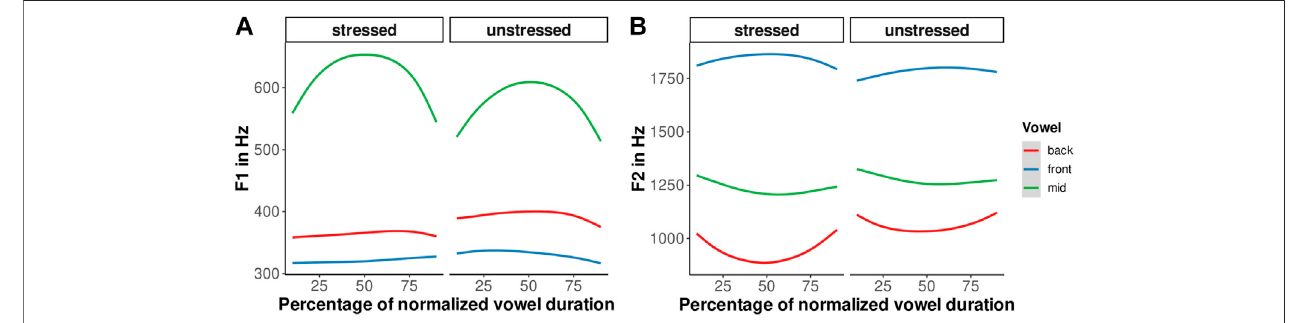
FIGURE 1 | Mean fi rst (A) and second (B) formant trajectories per vowel phoneme category (front, mid, and back) and primary lexical stress (unstressed and stressed).